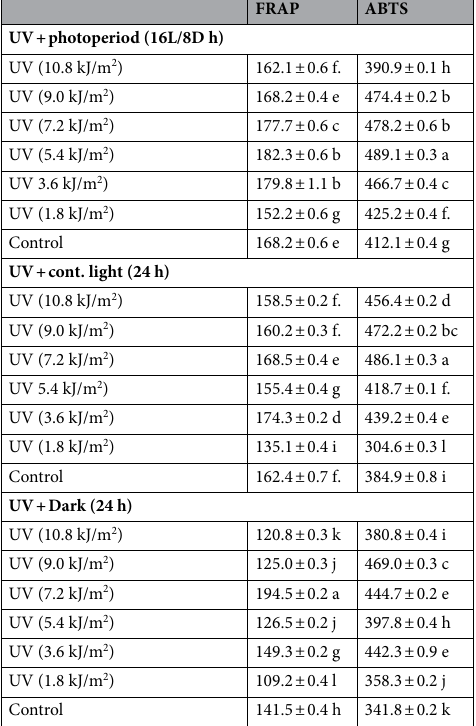
Table 2. Antioxidants potential activities of callus cultures of Fagonia indica elicited with UV-C radiations (0–10.8 kJ/m 2 ) and grown in different photoperiod regimes using FRAP and ABTS cell free in vitro assays. Antioxidant capacity of samples was expressed in terms of TEAC (Trolox C equivalent antioxidant capacity) per mg of DW. Values are the mean of three triplicates ± standard error (SE). Different letters represent significant differences between the various experimental conditions ( p <